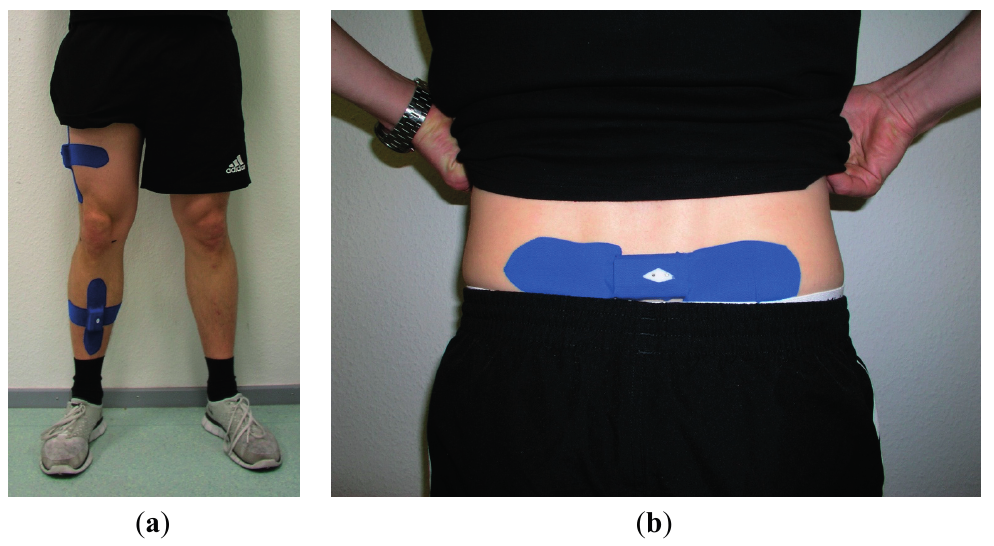
Figure 1. Elastic therapeutic tape was used to attach all sensors. ( a ) Display of the positions of the thigh and shank sensors; ( b ) Display of the pelvic sensor